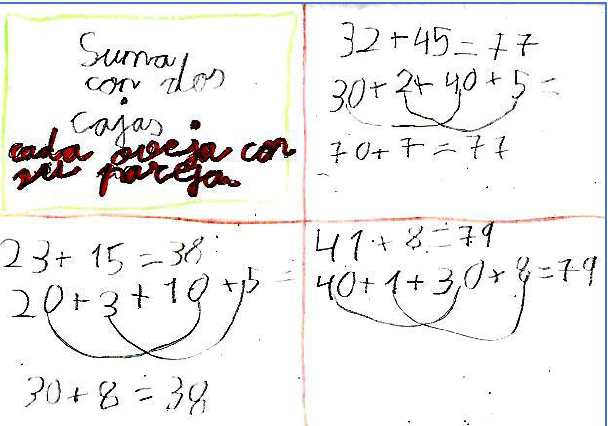
Figure 23. Addition with two boxes.